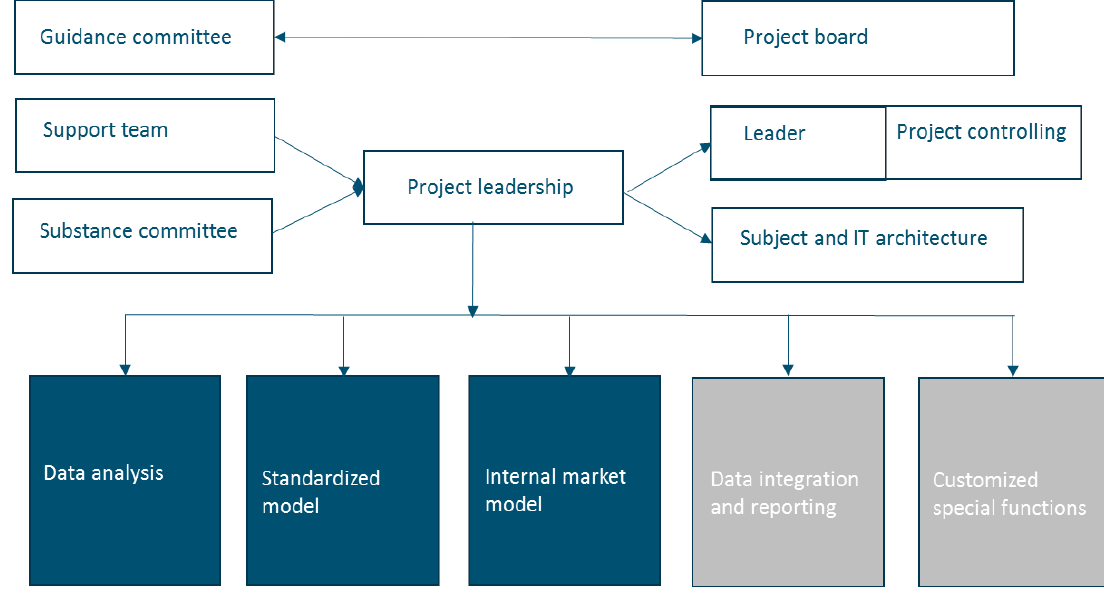
Figure 10. Organizational